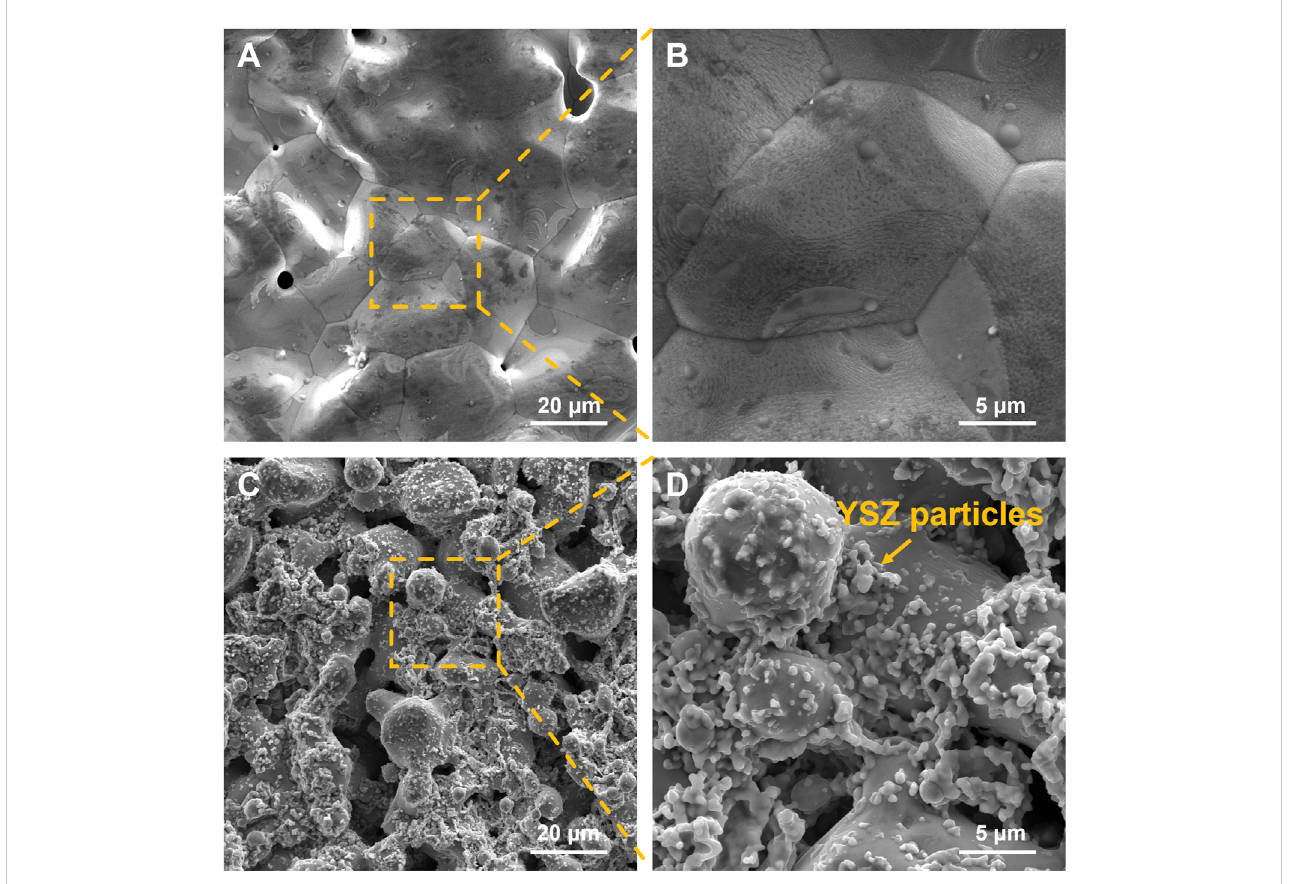
FIGURE 6 SEM images of the sintered SS430L substrate surface sintered at 1400 ° C for 3 h under puri fi ed 5% H 2 /Ar with 24% starch only (A) and (B) and with 24% starch plus 10 wt.% of YSZ (C) and (D) .